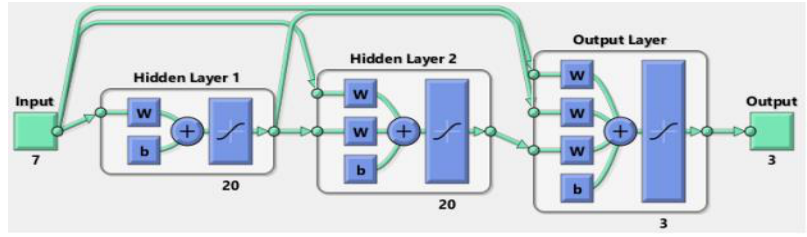
Figure 12. ANN Model for Reference Current in SIMULINK.